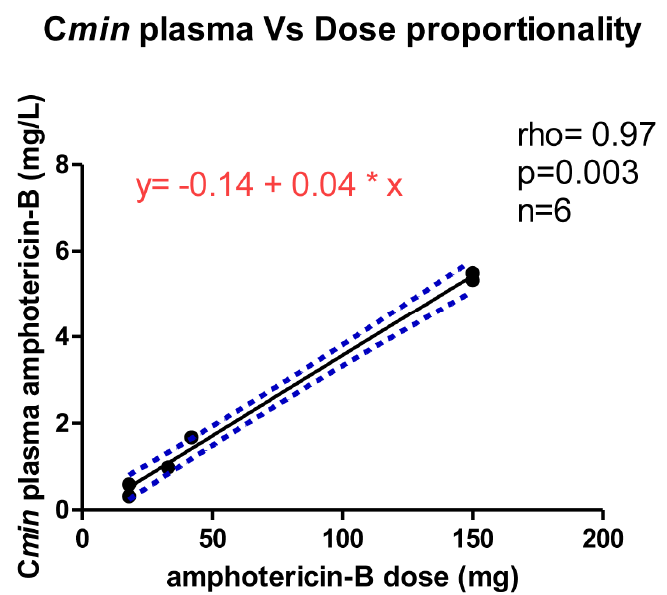
Figure 2. Dose proportionality evaluation. Linear regression model with the best fit line (black) and 95% CI (dotted blue lines), describing correlation between amphotericin-B C min in plasma and dose administered. The asterisk (*) indicates “times” the value on the X axis.